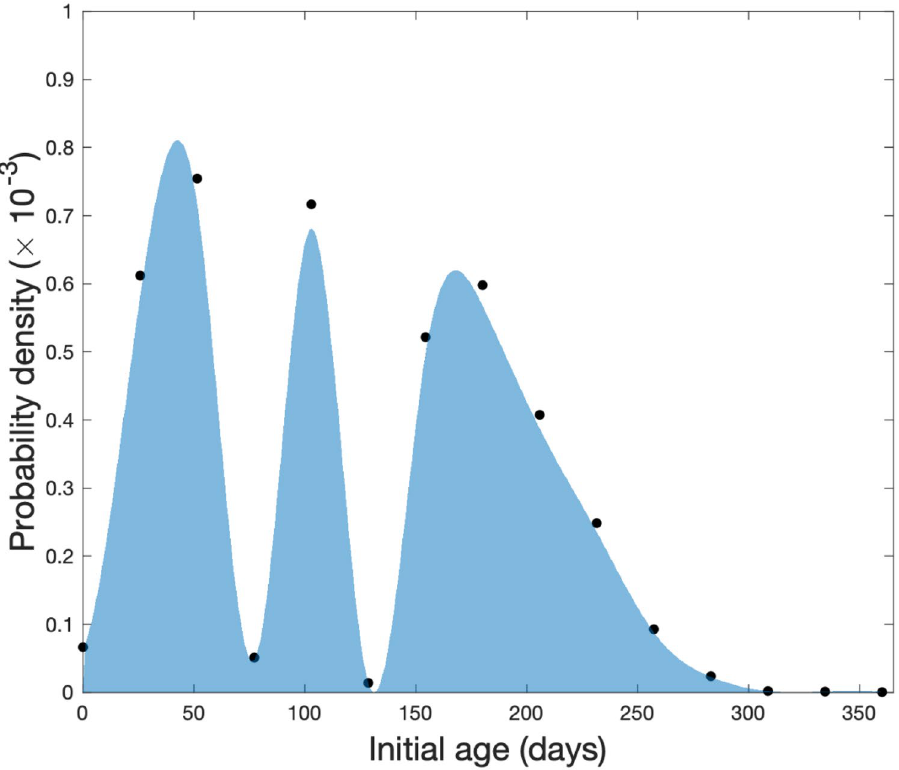
Figure 4. An example of age-distribution produced by maximum likelihood method using hypothetical